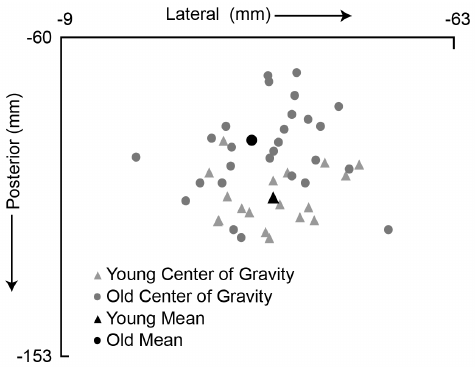
Figure 2. Center of gravity in young and old individuals. Location of center of gravity across all participants in both groups. As the averages demonstrate, center of gravity in older participants was more